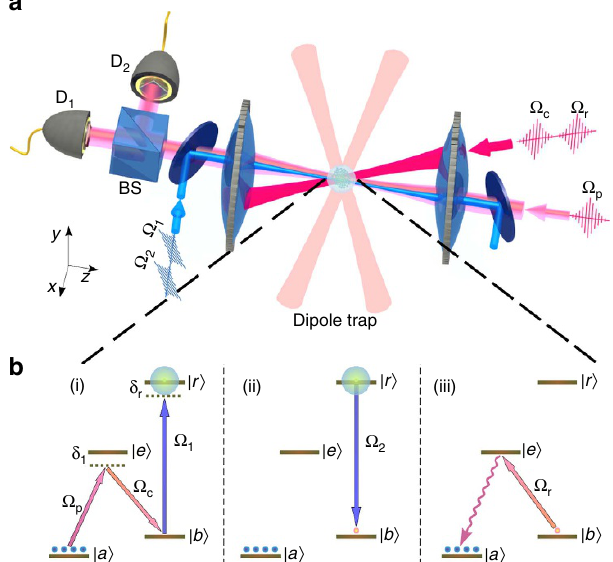
Figure 1 | Overview of the experiment. ( a ) Essential elements of the experimental set-up. An ultra-cold 87 Rb gas is confined in a crossed dipole trap formed by two 1,064nm fields. Two 795nm beams (probe and control) and a 297nm beam are focused on the atomic sample with waists ( o p , o c , o 1,2 ) ¼ (5, 25, 18) m m, respectively. The probe and control beam are aligned with an angle 3 (cid:2) , while the 297 beam counter propagates with the probe beam. Probe O p and control O c laser fields are orthogonally circularly polarized. To avoid the dephasing of Rydberg state induced by inhomogeneous light shifts, the dipole trap is turned off before the Rydberg excitation field O 1 and switched back on after the Rydberg transfer field O 2 . ( b ) Level diagram and experimental protocol. (i) Atoms are initially prepared in state | a i by means of optical pumping. The atomic ensemble is driven from | a i to | b i by the probe field O p and control field O c . Next, the 297nm field O 1 couples | b i directly to the Rydberg state | r i , creating a singly excited Rydberg state. (ii) By applying the 297nm field O 2 , the short-lived Rydberg excitation is mapped into the ground state | b i for storage. (iii) The ground-state excitation is retrieved by the read field O r and measured at D 1 and D 2 . The atomic levels involved are | a i¼ |5 s 1/2